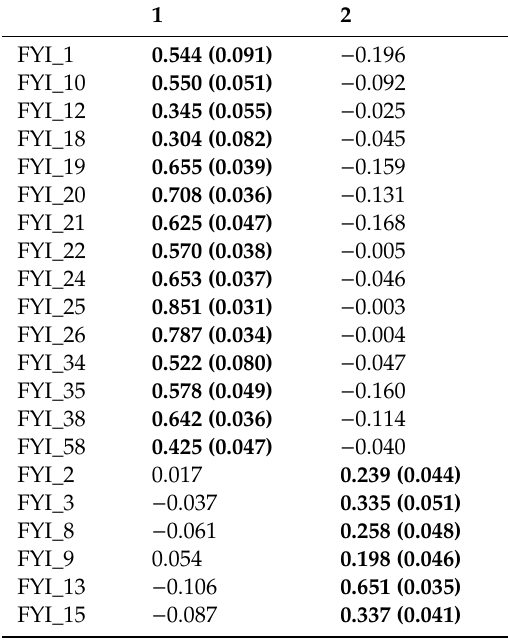
Table 7. Exploratory Factor Analysis (EFA) results (standard errors between